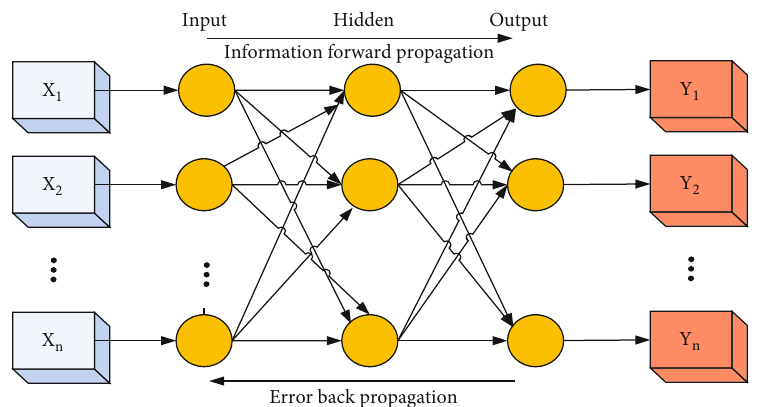
Figure 1: Topological structure of BP neural